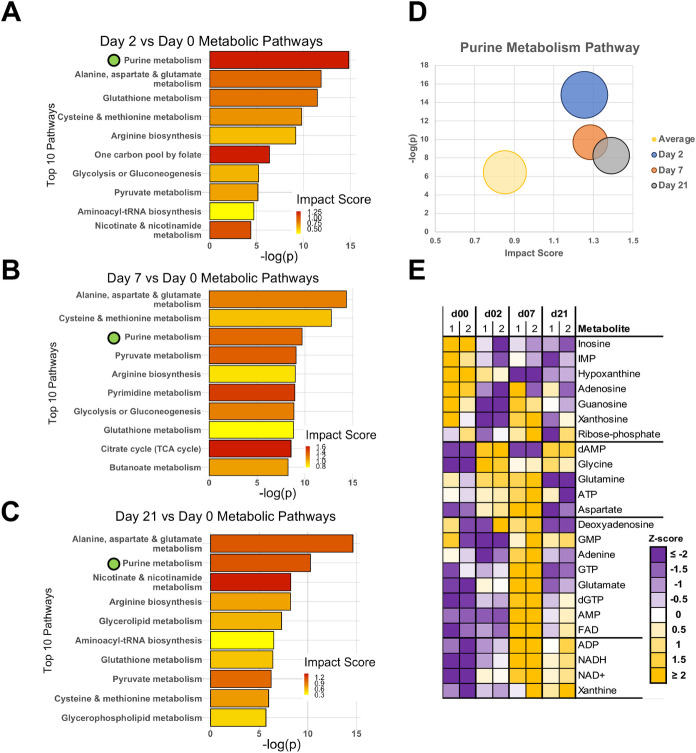
Metabolomic analysis of EBV-mediated B-cell reprogramming.(A-C) Significantly altered metabolites and genes (|FC| >2, FDR < 5%) were used in an integrated pathway analysis to identify altered metabolic pathways at Day 2 (A), Day 7 (B) and Day 21 (C) post-infection. Green marker was used to highlight purine metabolism. (D) Bubble chart showing significant disruption of purine metabolism compared to the average significantly altered pathway. Bubble size represents the ratio of significantly altered metabolites and genes in the pathway compared to the number expected due to chance. (E) Heatmap showing relative levels of metabolites in the purine metabolism pathway. Metabolites are grouped based on general trend of metabolite levels across the complete time course of infection.